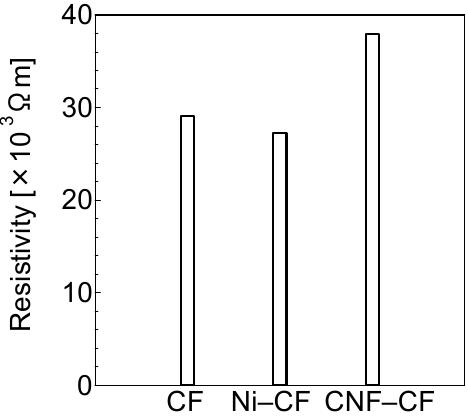
Figure 9. Resistivity of each carbon fiber.